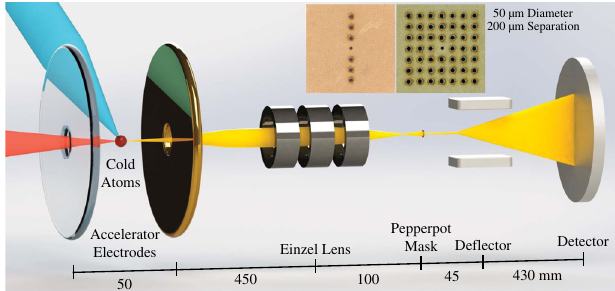
FIG. 1. An overview of the CAES and streaked pepperpot apparatus. Atoms were cooled and trapped in a magneto-optic trap (not shown) before ionization and acceleration along the beamline. Blue and red indicate the two ionization laser beams and yellow indicates the electron beam path. Shown inset are images of the one- and two-dimensional pepperpot masks both with 50 μ m diameter apertures separated by 200 μ